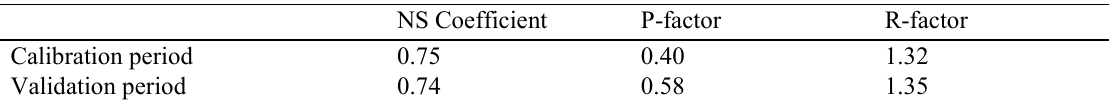
Table 2 The values of evaluation criteria in calibration and validation period.